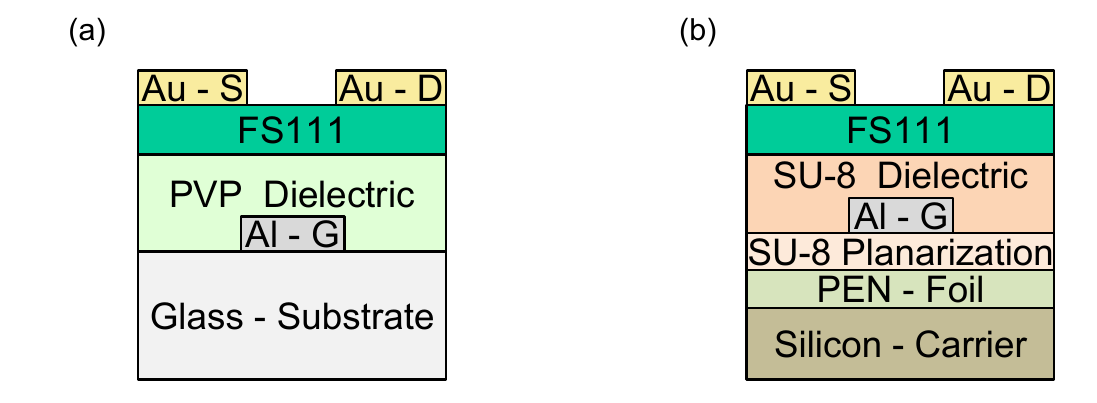
Figure 4. Device architectures for OFETs based on ( a ) PVP and ( b ) SU-8 dielectrics.